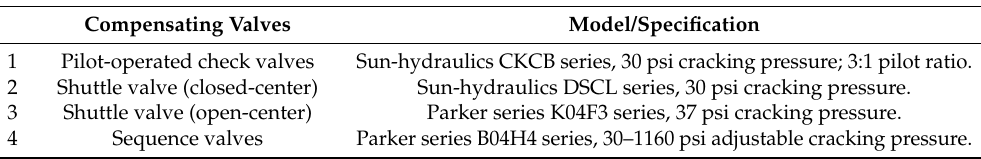
Table 2. Compensating valves specifications.